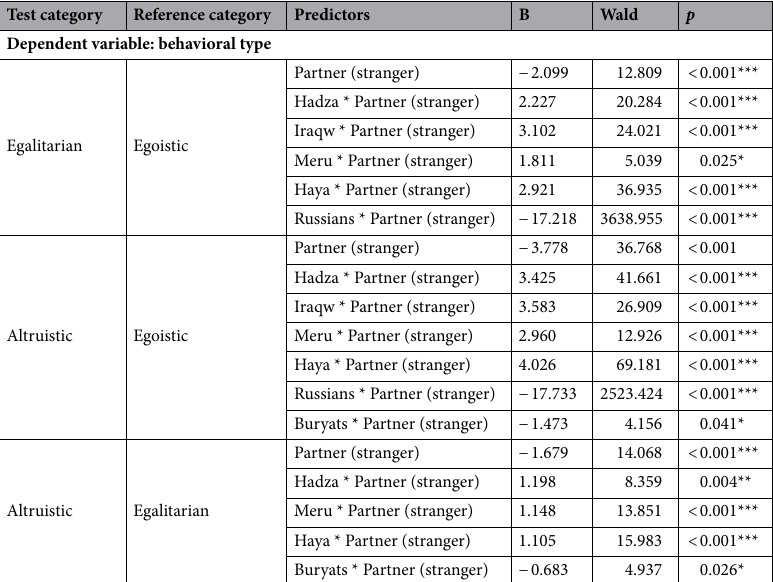
Table 4. Ethnic group and parochial effects. Multinomial logistic regression model: parameter estimates. Behavioral types: Egoistic, Egalitarian, Altruistic, and Mixed. Only significant results for three first categories are presented. B—regression coefficient, Wald—test statistics, p —statistical significance (* p < 0.05, ** p < 0.01, *** p < 0.001). Full model is available in Supplementary Table 1.